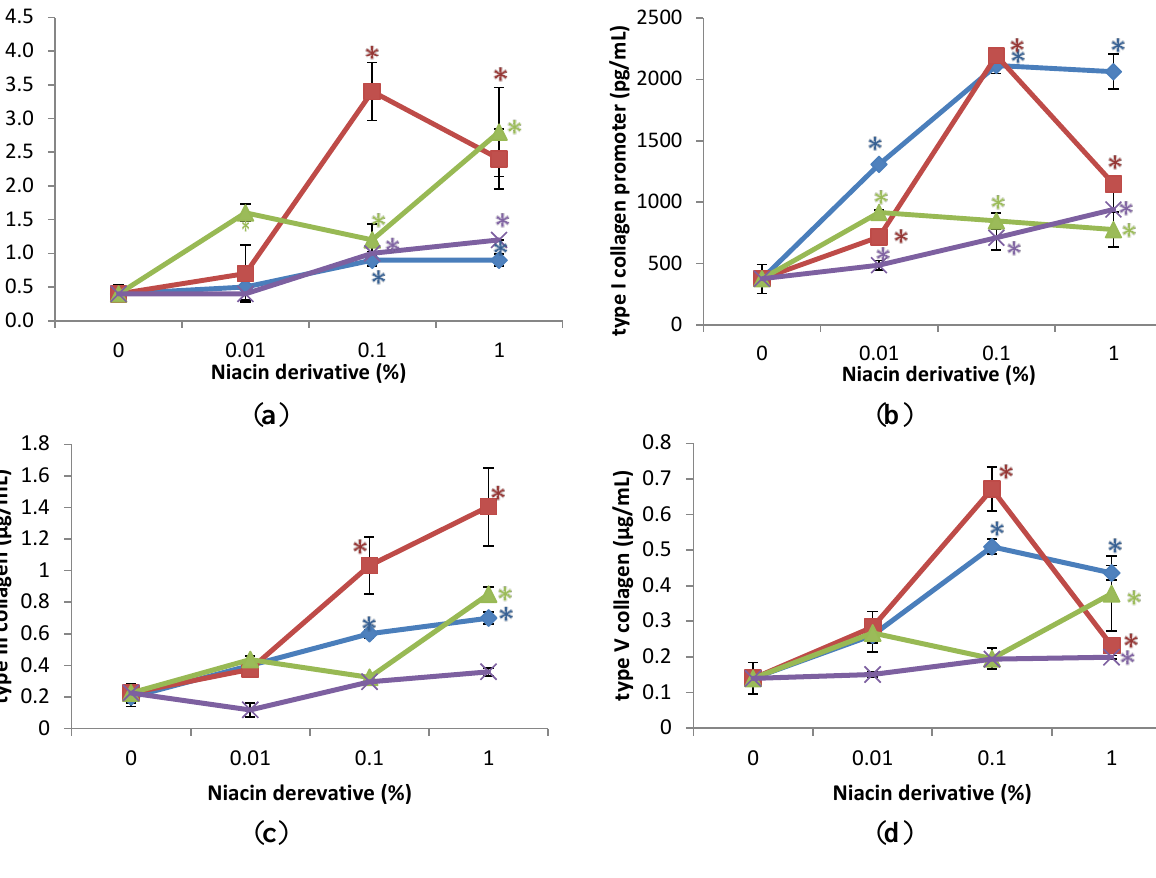
Figure 2. Stimulation of type I collagen protein ( a ); type I collagen promoter activity ( b ); type III collagen protein ( c ); and type V collagen protein ( d ) by nicotinamide (green line), 2,6-dihydroxynicotinamide (red line), 2,4,5,6-tetrahydroxynicotinamide (violet line), and 3-hydroxypicolinamide (blue line) in UVA-radiated dermal fibroblasts; * p < 0.05, relative to UVA radiated control cells, error bars ( a – d ) represent standard deviation, n = 4. Relative to the expression of type I collagen protein (0.42 μg/mL as 100%) in UVA-radiated control cells (0% niacin derivative), 0.1% and 1% of each of the niacin derivatives stimulated type I